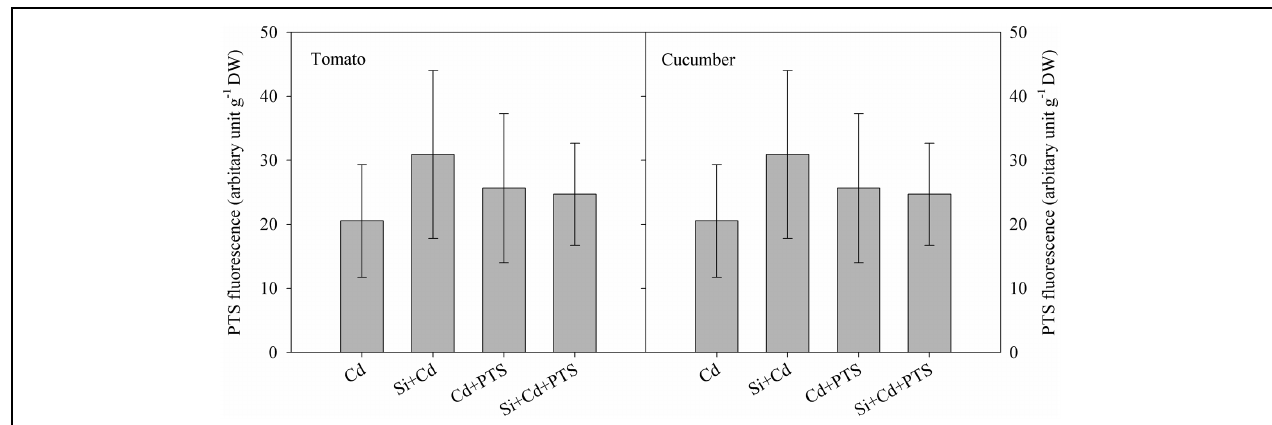
FIGURE 3 | Fluorescence of leaves as affected by Cd and PTS